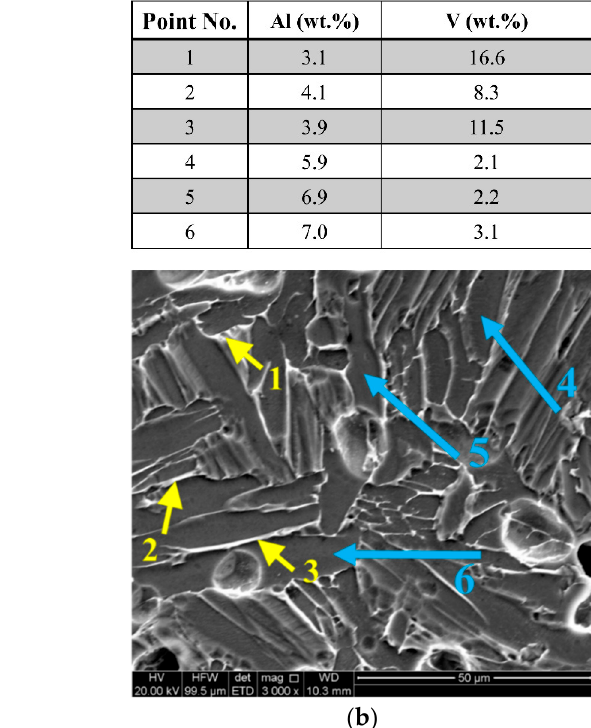
( b ) Figure 8. Optical micrographs of transverse sections of L-PBF parts after etching ( a ) horizontally built cylinder and ( b ) vertically built cylinder. 3.2. Micro and Nano-Hardness Characteristics Figure 9 shows the tabulated results and a graph of the micro-hardness versus the porosity content for both the PM and L-PBF samples. For PM samples, the hardness in- creases with increasing compaction pressure and sintering temperature. At the same sin- tering temperature, the hardness value of a specimen compacted at a pressure of 435 MPa is lower than specimens compacted at a higher pressure of 735 MPa; this is attributed to the various levels of porosity content, Table 3, induced by various compacting pressures in the green samples. However as previously explained, the sintering temperature seems to be more effective in lowering the level of porosity than the compacting pressure.